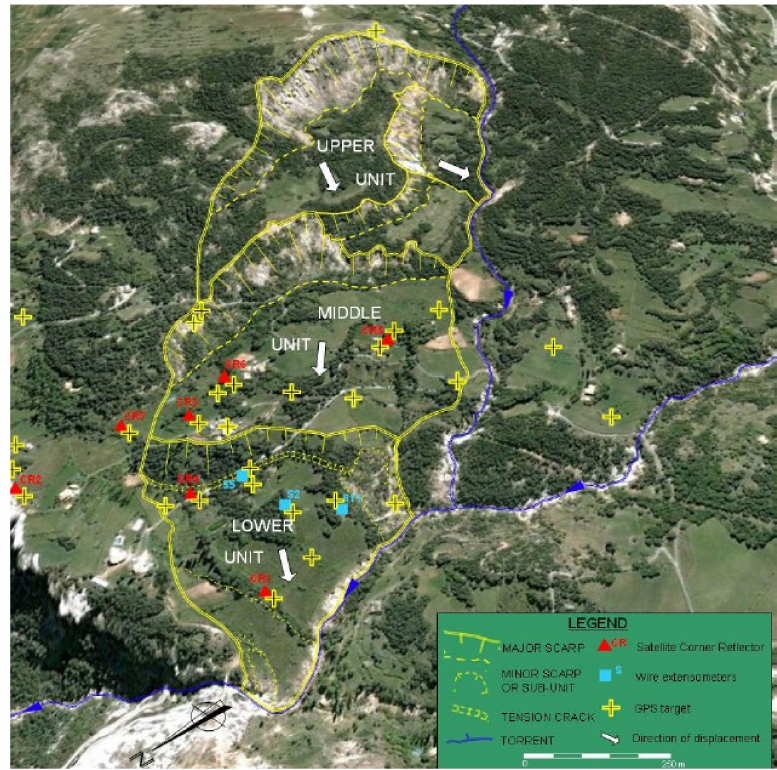
Figure 3. Geomorphological scheme of the Vallcebre landslide superimposed over a vertical aerial image. Several GPS benchmarks, corner reflectors and borehole extensometers have been highlighted with